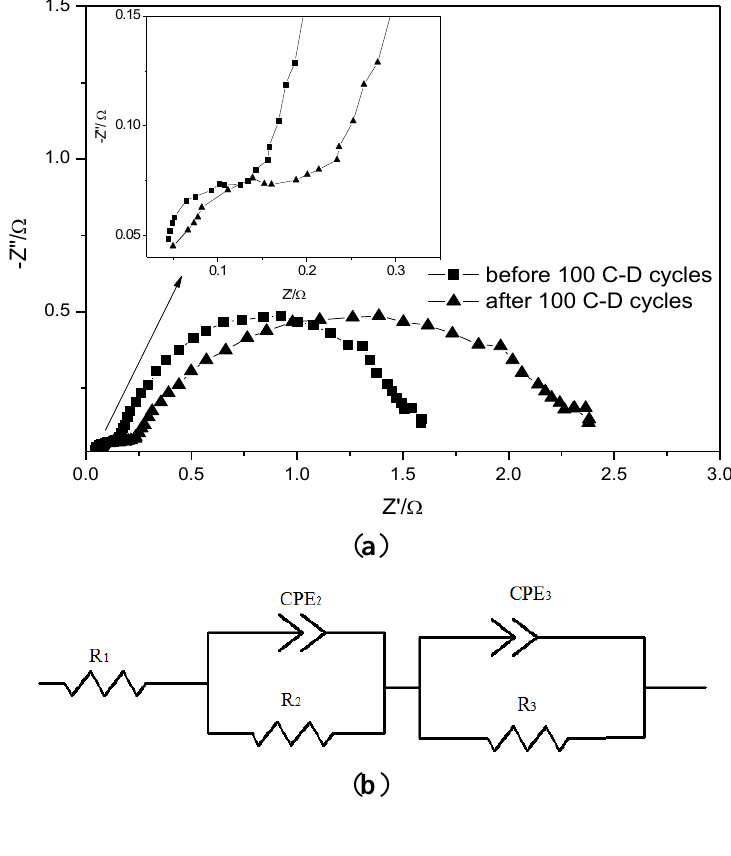
Figure 4. ( a ) Nyquist plot of cell #1 at a load current density of 25 mA·cm −2 before and after 100 C-D cycles; ( b ) the equivalent circuit for the impedance